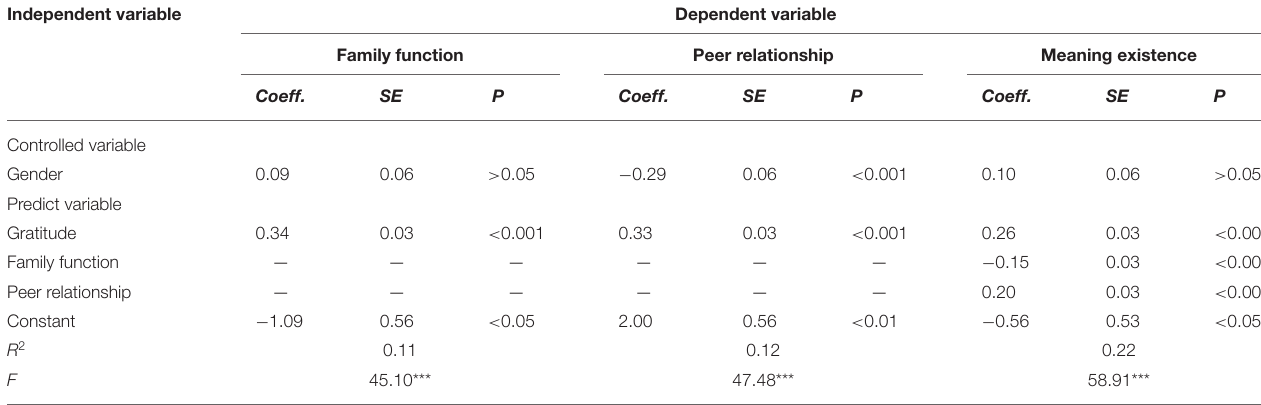
TABLE 2 | Results of PROCESS test.